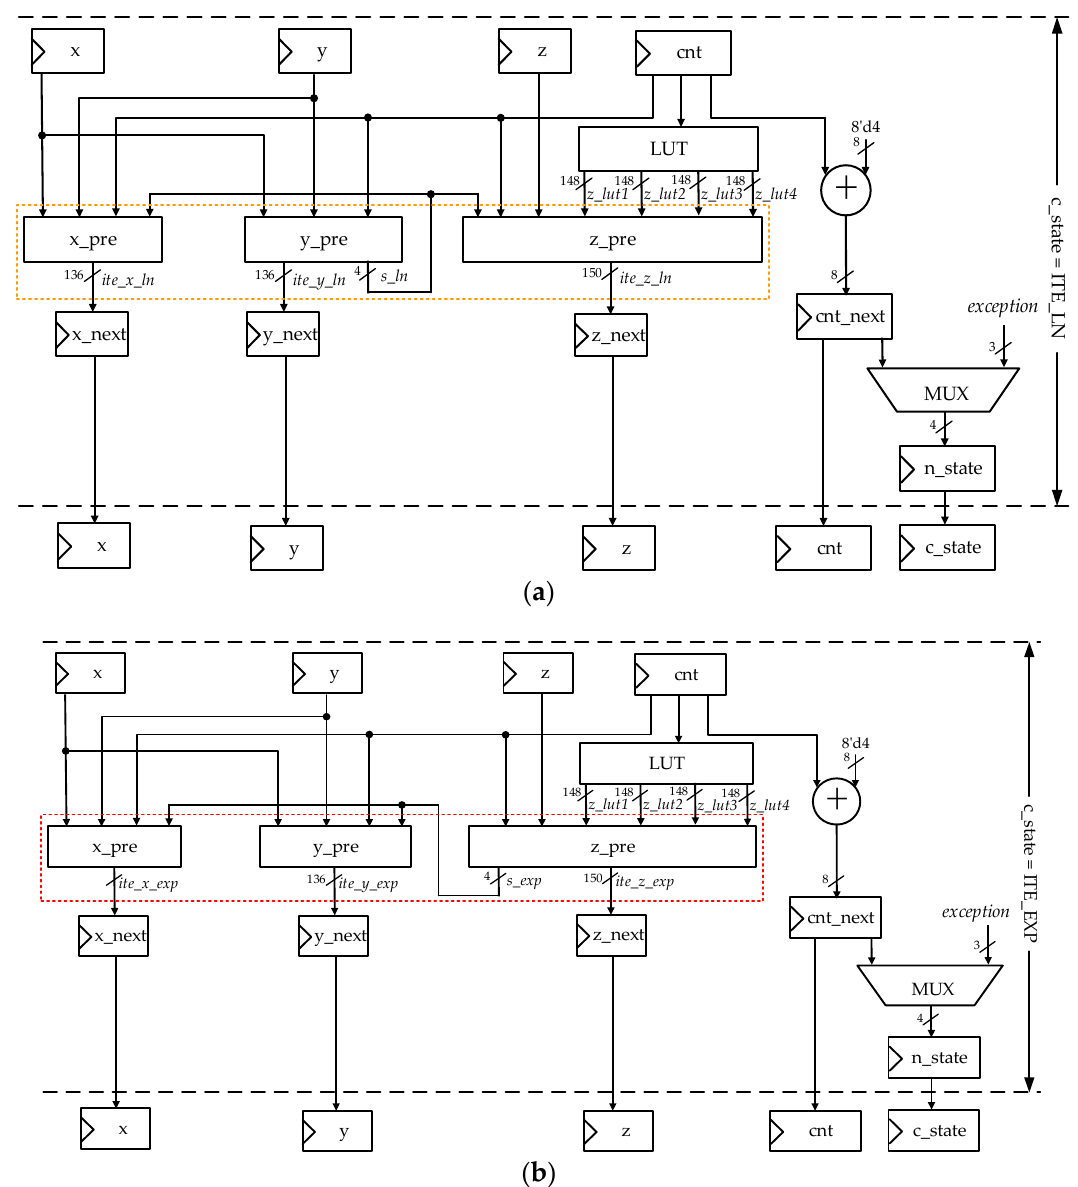
Figure 7. ( a ) Architecture of the state ITE_LN; ( b ) architecture of the state ITE_EXP.